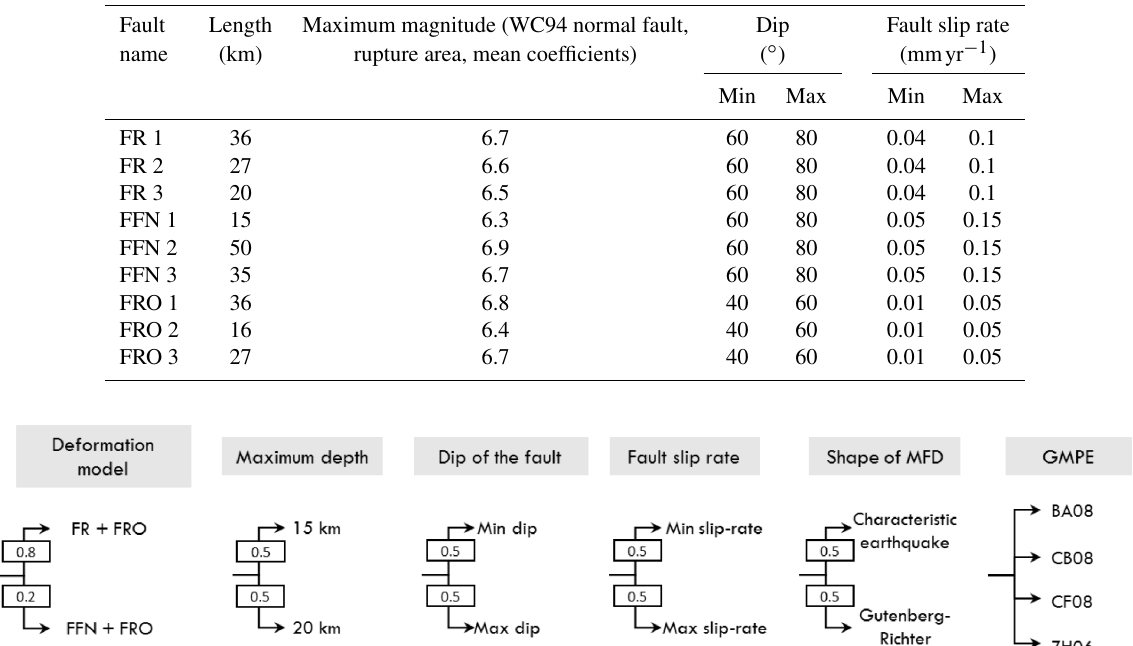
Table 1. Example of fault parameters considered in the calculations (seismogenic depth of 15km, steepest dip of the faults). FR is Rhine River fault, FFN is Black Forest fault, FRO is West Rhenish fault. (See Fig. 4 of Part 1, Jomard et al., 2017.)